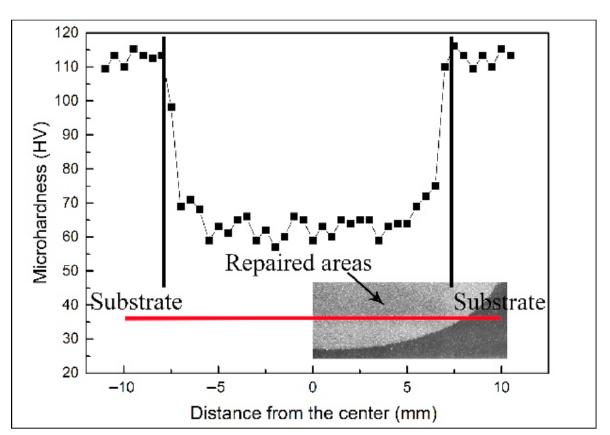
Figure 6. Microhardness of the samples repaired with the cold spray